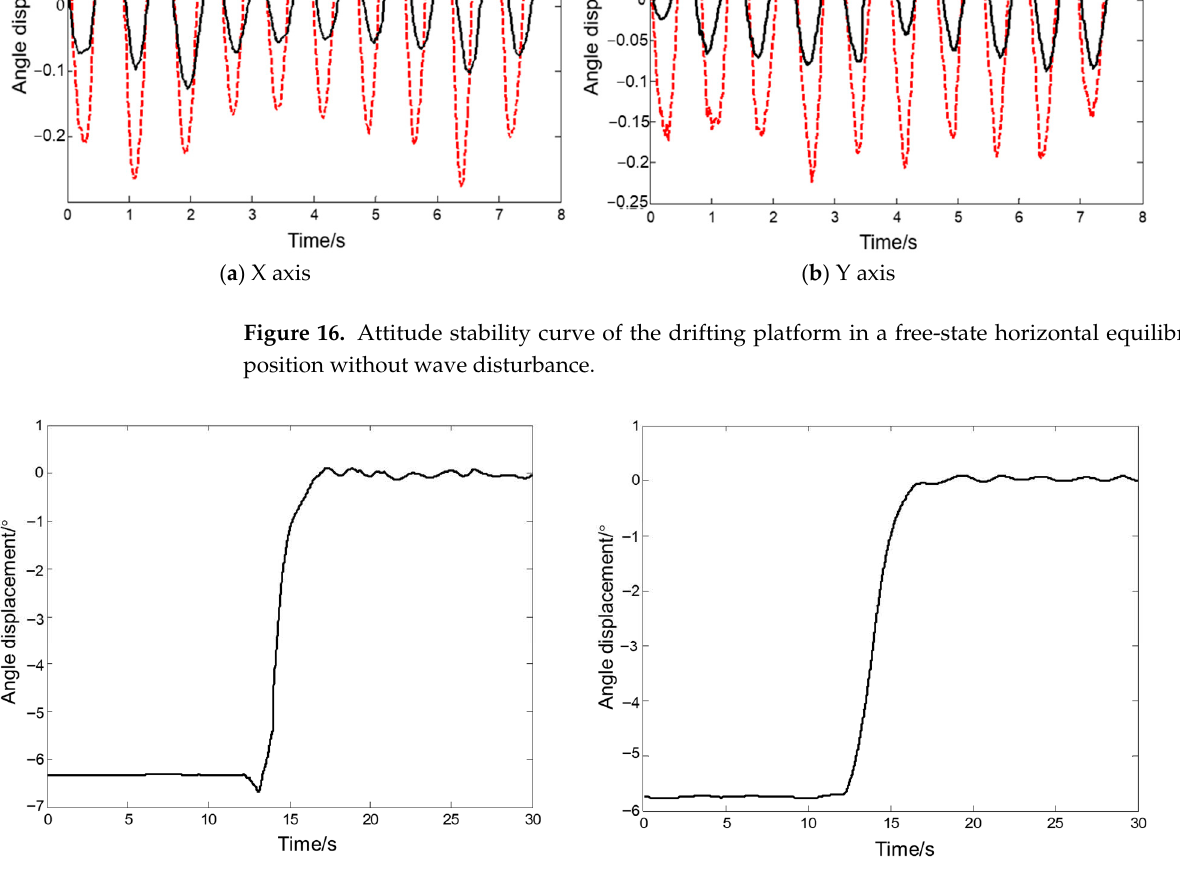
Figure 16. Attitude stability curve of the drifting platform in a free-state horizontal equilibrium po- sition without wave disturbance.